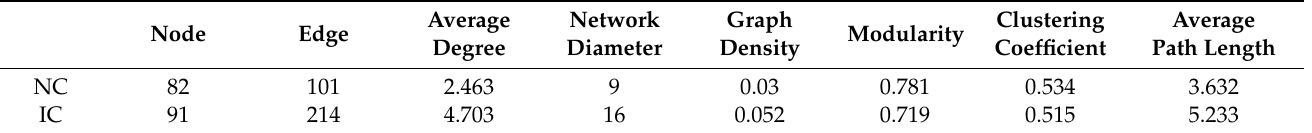
Table 3. Topological properties of bacterial co-occurrence networks under different treatments.